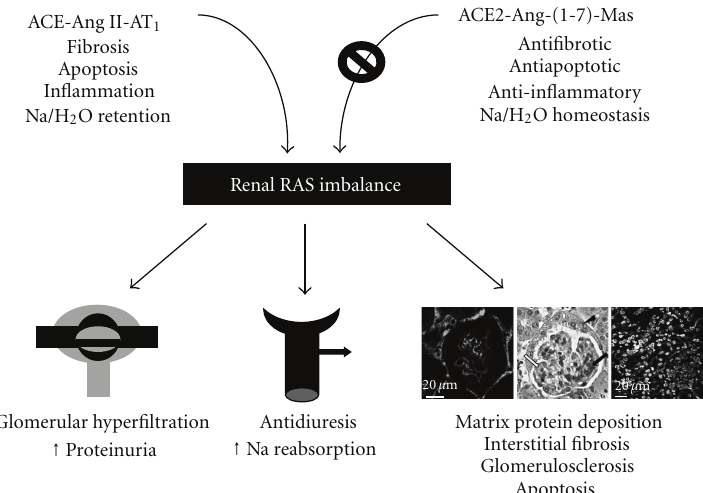
Figure 1: Proposed mechanisms for the role of ACE-Ang II-AT 1 receptor axis in excess of ACE2-Ang-(1-7)-Mas receptor axis at renal